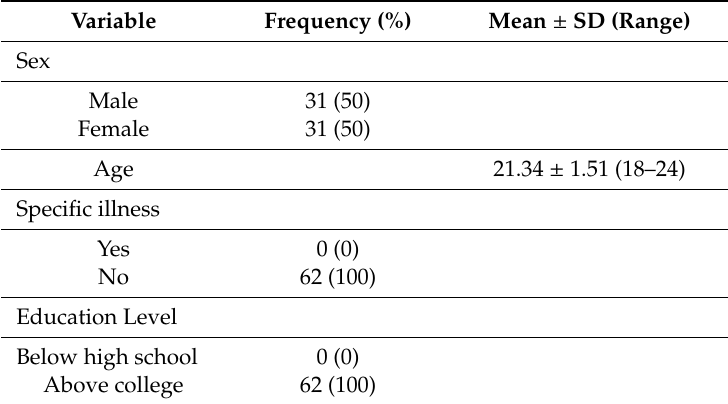
Table 1. General characteristics of all participants ( N =